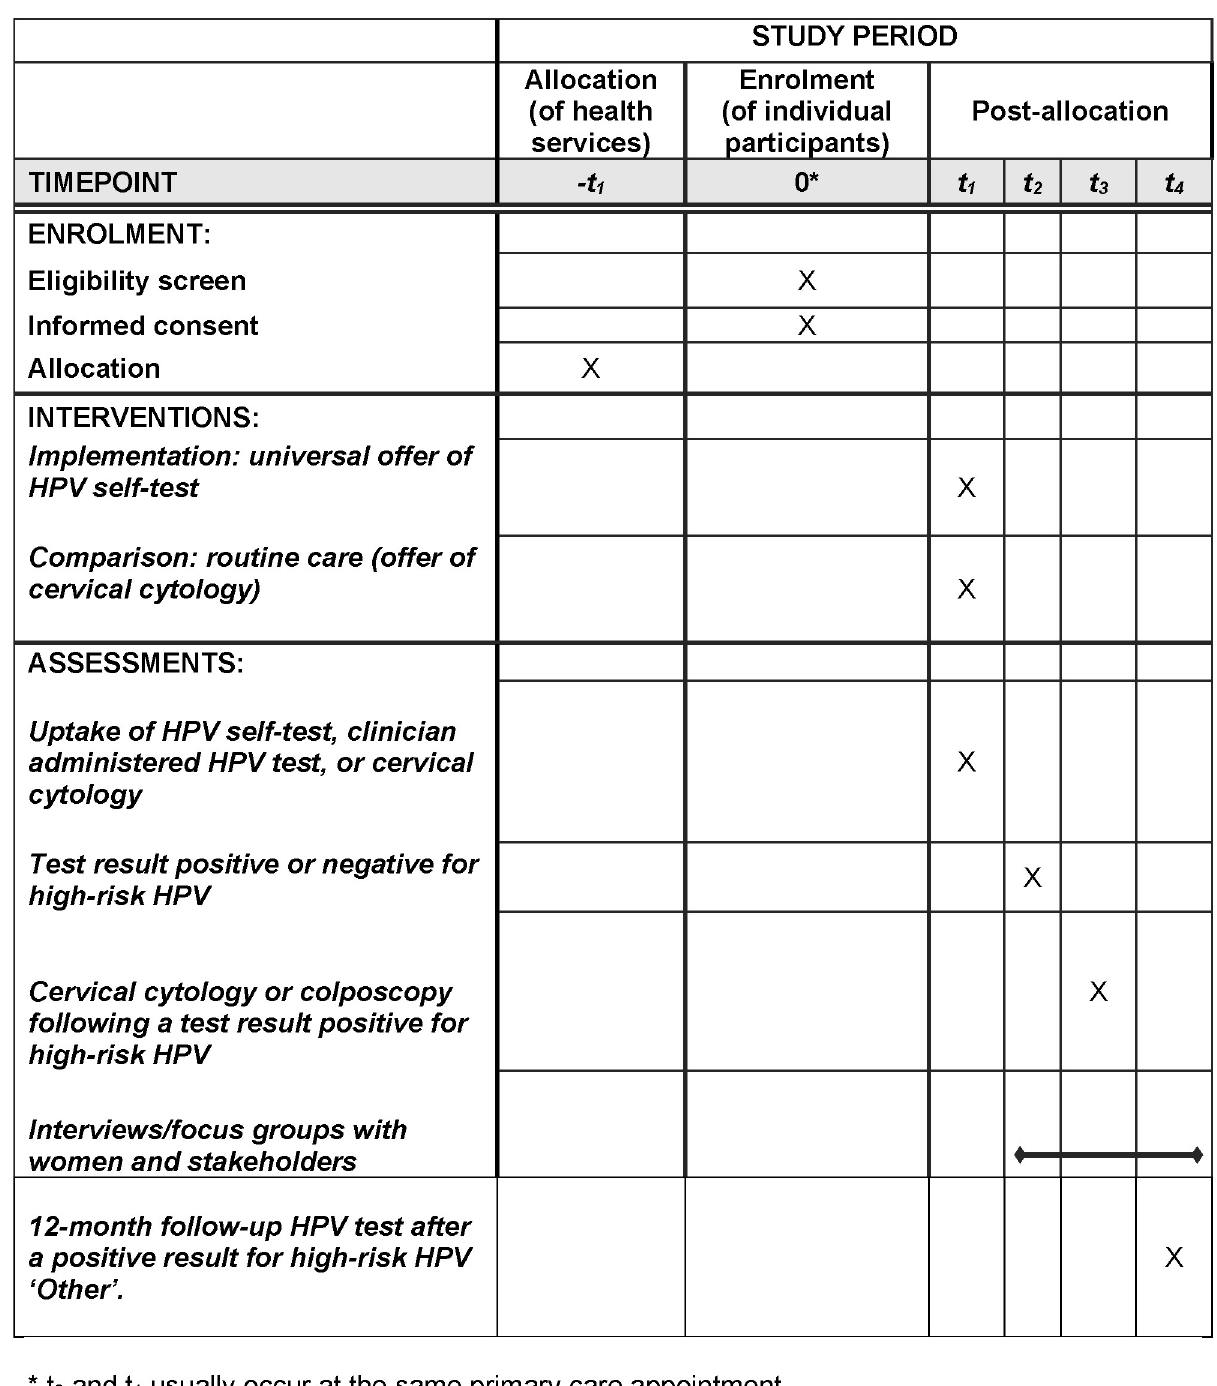
Fig 1. Te Ara Waiora–Implementing human papillomavirus (HPV) primary testing in Aotearoa New Zealand: Schedule of enrolment, interventions, and assessments.